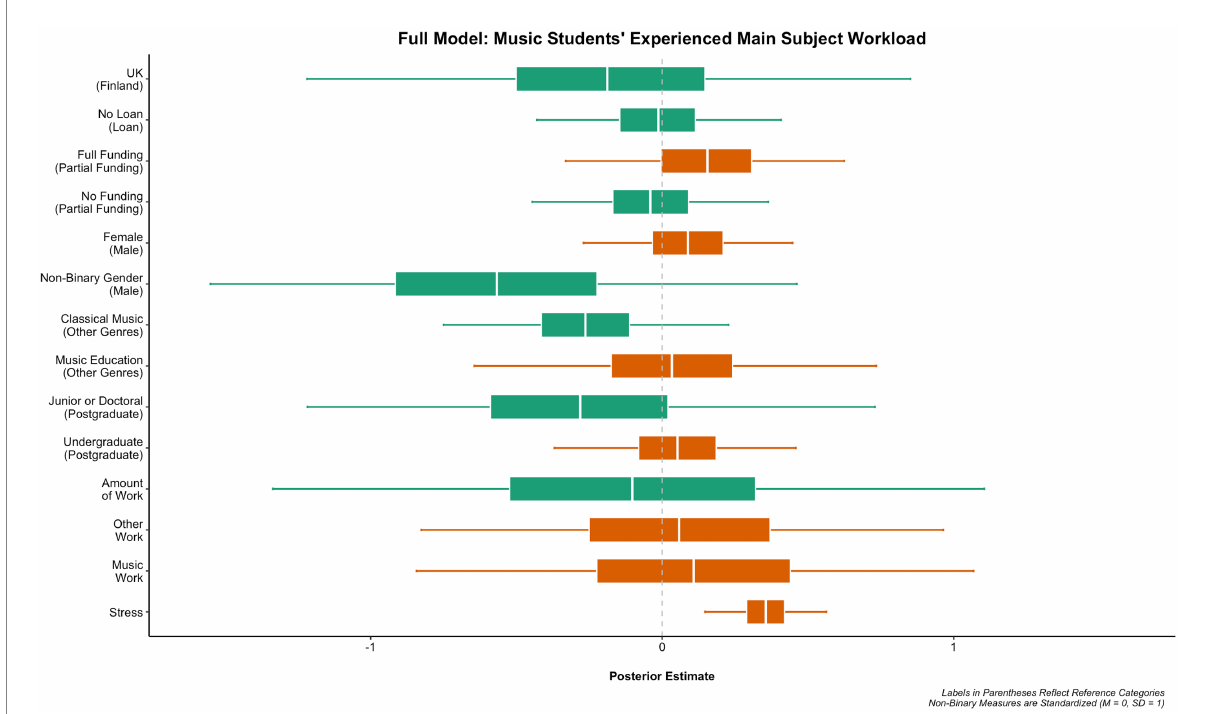
FIGURE 6 Population-level predictors of experienced main subject workload, derived from a Bayesian mixed-effect probit regression. The boxes indicate 50% posterior intervals, and the lines indicate 95% posterior intervals. With binary items, the left-hand side boxes indicate a smaller effect on workload than in the reference group in brackets, and the right-hand side boxes indicate a greater effect on workload than in the reference group in brackets. With the working and stress items (the four bottom items on the figure), the left-hand side boxes indicate a negligible effect on workload and the right-hand side boxes indicate a greater effect on workload the nearer the box is to the right-hand